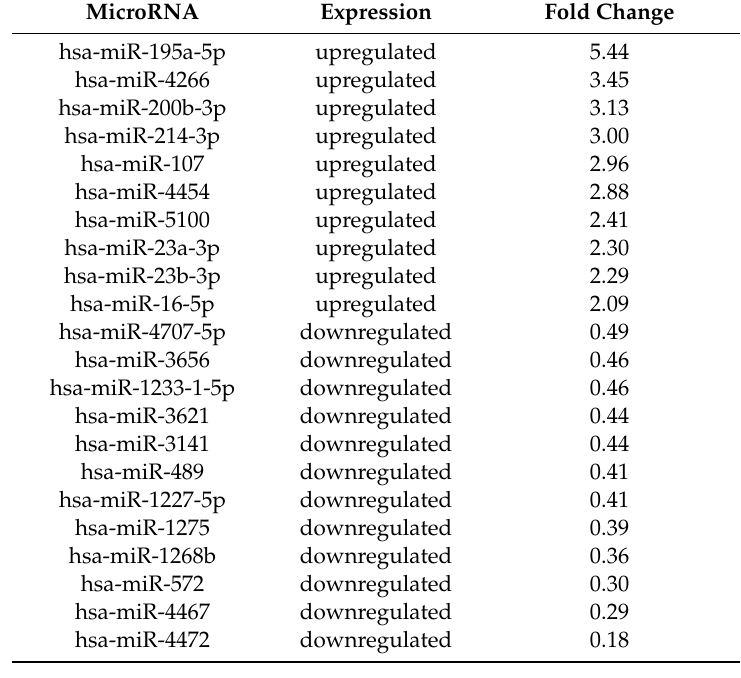
Table 1. Dysregulated microRNAs associated with chemoresistant breast cancer patients evaluated by transcriptome analysis.